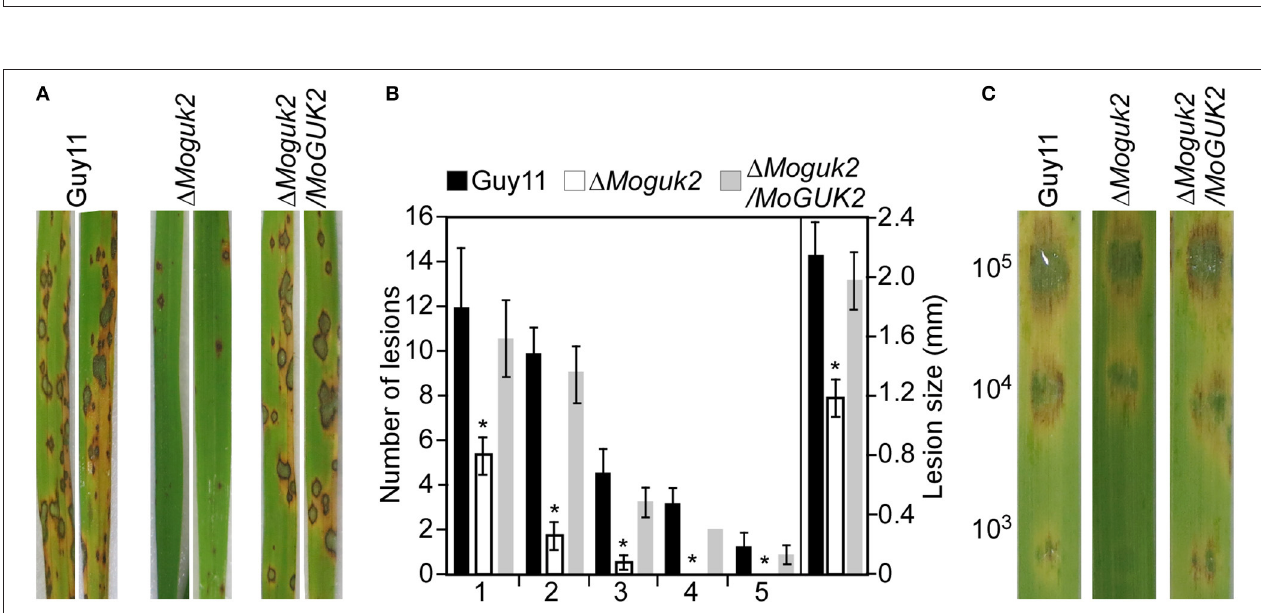
FIGURE 5 | The 1 Moguk2 mutant attenuates virulence. (A) Conidial suspensions (5 × 10 4 spores/ml) from the wild type, the 1 Moguk2 mutant and the complemented transformant were sprayed onto 2-week-old rice seedlings, and photographed at 7 days post-inoculation (dpi). (B) Statistical analysis of the number of lesions in each type, and the average lesion size of the indicated strains. Lesions on 10 diseased rice leaves were counted per replicate, and the experiment was repeated three times. Error bars are standard deviations and asterisks represent significant differences at P < 0.01. (C) Conidial suspensions (1 × 10 5 , 1 × 10 4 , and 1 × 10 3 spores/ml) from the indicated strains were dropped onto 1-week-old detached barley leaves, and photographed at 5 dpi.